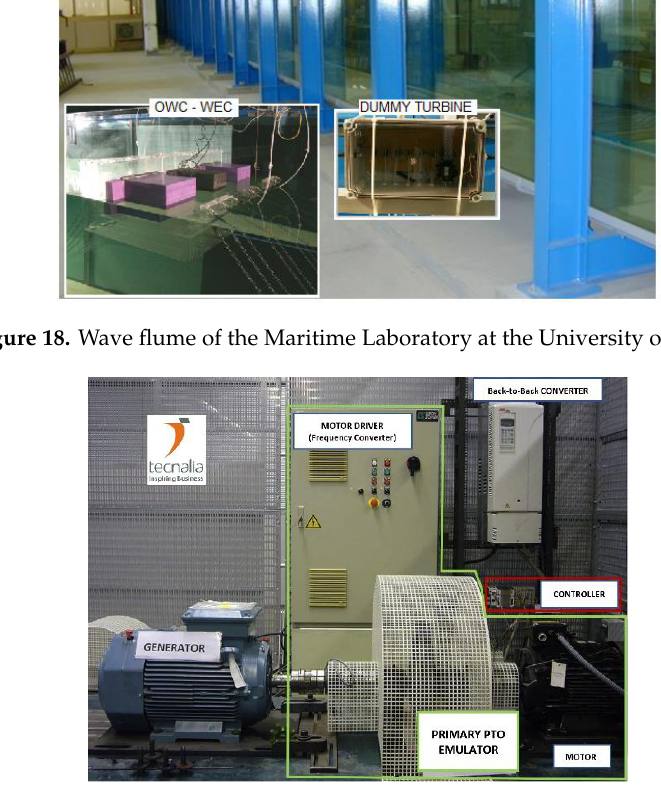
Figure 19. Test rig at the Tecnalia Electrical PTO Lab.